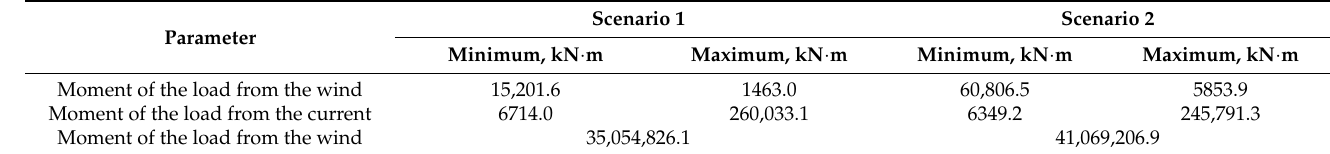
Table 13. Moments of integral loads on platforms according to Scenario 1 and Scenario